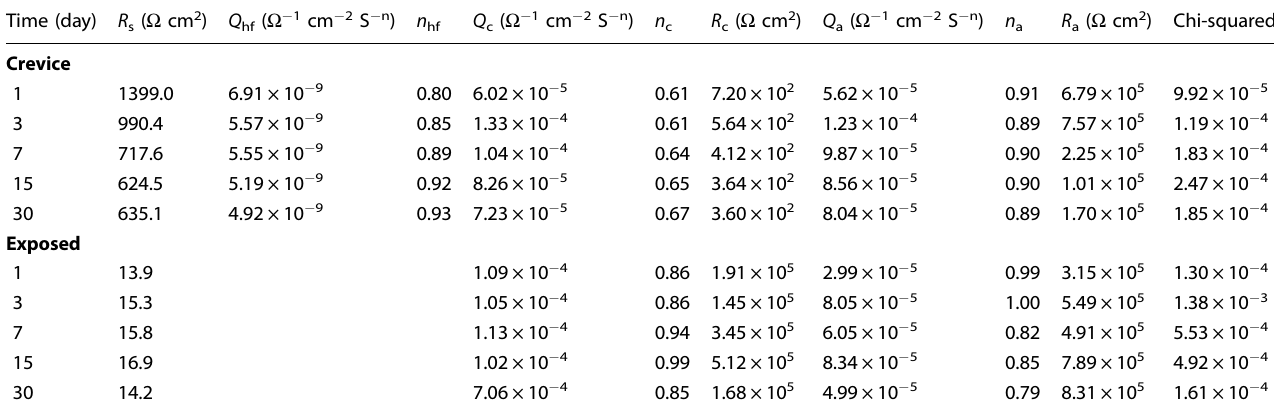
Table 1. Fitted EIS parameters of the steel